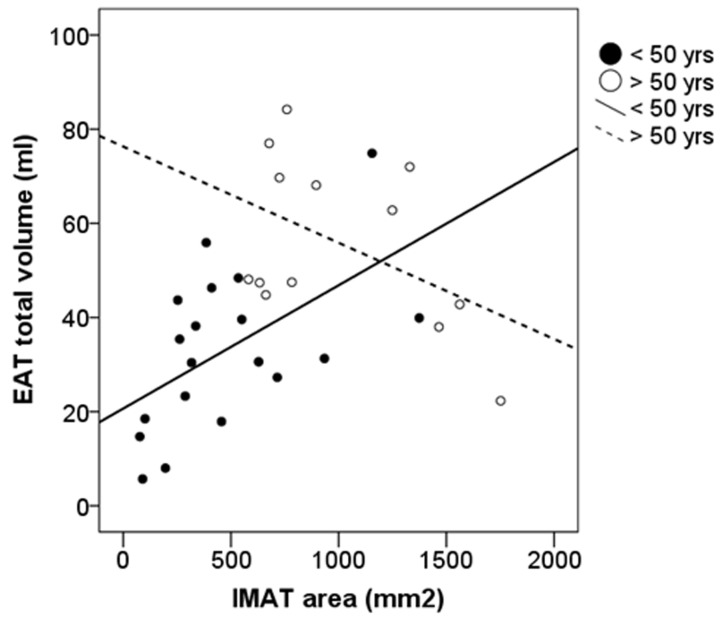
Correlation of IMAT with EAT according to age.Correlations between IMAT area with EAT total volume. Solid lines represent the correlation in younger subjects (≤50 years) (β = 0.6, p = 0.007). Dashed lines represent the non significant correlation in older subjects (>50 years) (β = −0.3, p = ns).